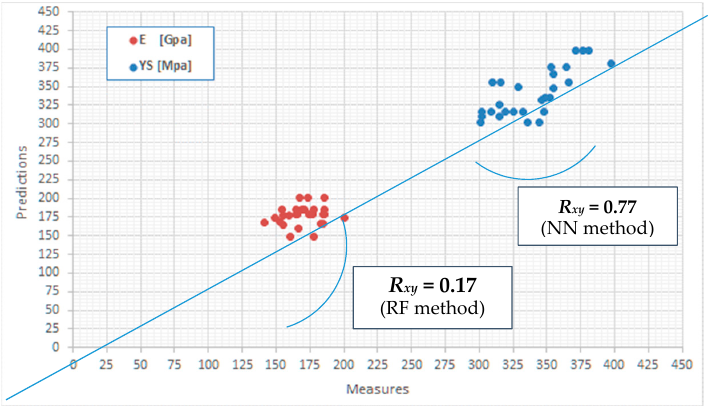
Figure 4. A graphical representation of data with different Pearson correlation coefficients. It is the case of YS (MPa) and E (GPa) for SGI with coefficients of, respectively, 0.74 (NN) and 0.17 (RF).